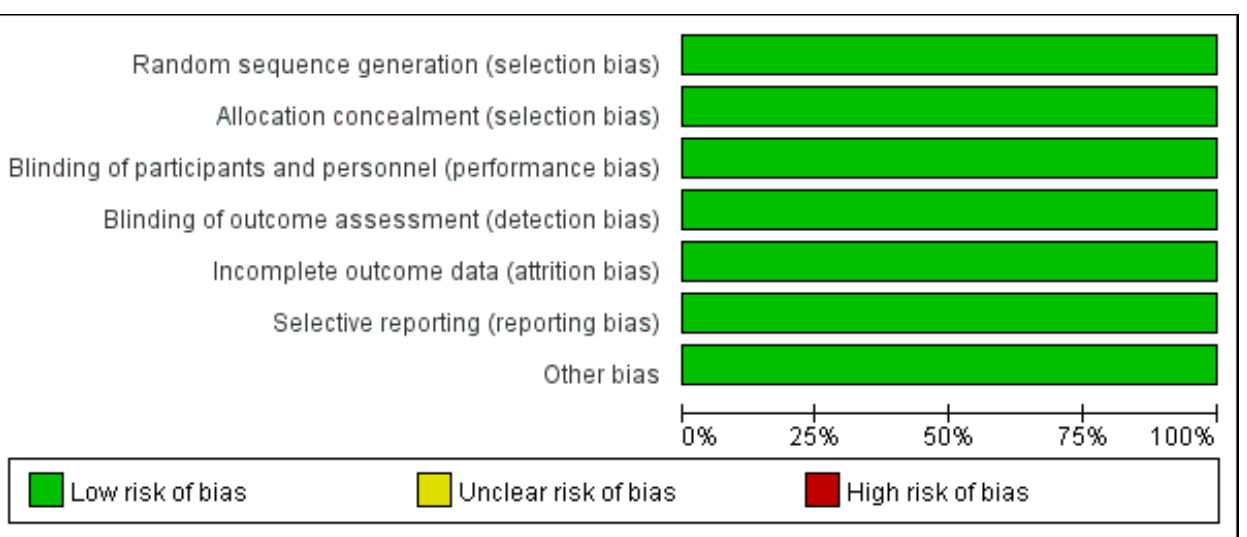
Figure 1. Preferred reporting items for systematic reviews and meta-analyses (PRISMA) flow chart.